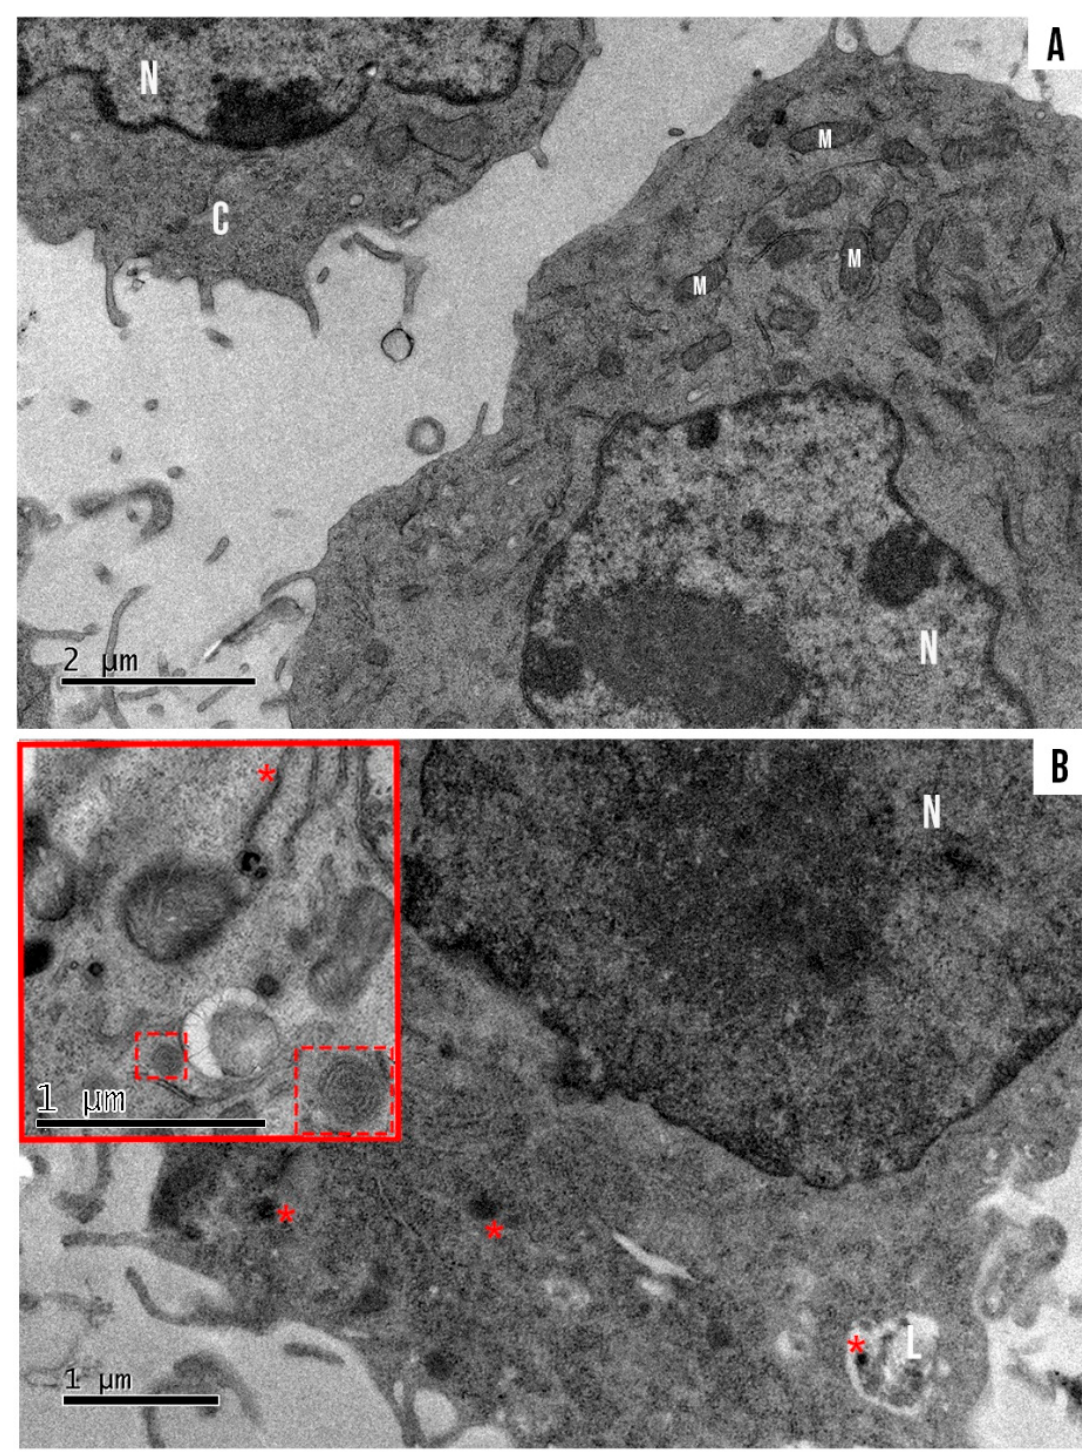
Figure 8. ( A ) Ultrastructure of B16-F10 treated with SLN-AlPc for 15 min. ( B ) Internalized aggregated SLN-AlPc is present in B16-F10 (*) and in a liposome (L). Melanosoma is present in the melanocyte cells (slashed box). Nucleus (N), mitochondria (M), and cytoplasm (C) are indicated in the image. During the analysis of SLN-AlPc internalization by confocal laser fluorescence microscopy, it was noted that the AlPc (red) was already colocalized with the nucleus labeled with DAPI (blue) in B16-F10 cells just 15 min after the treatment (Figure